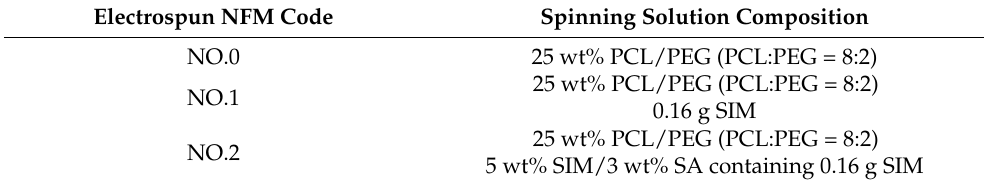
Table 1. Codes of electrospun NFMs and their corresponding spinning solution